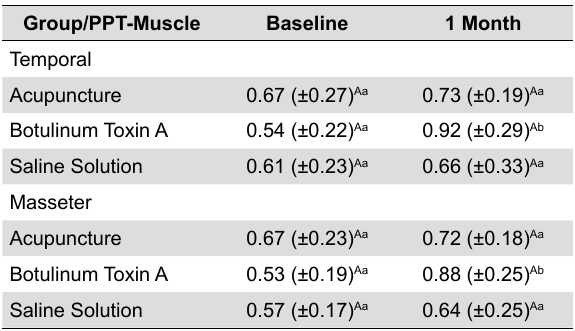
Table 1- Mean and standard deviation (SD) of pain pressure threshold (kg/cm -2 ) for each group, before and after treatments